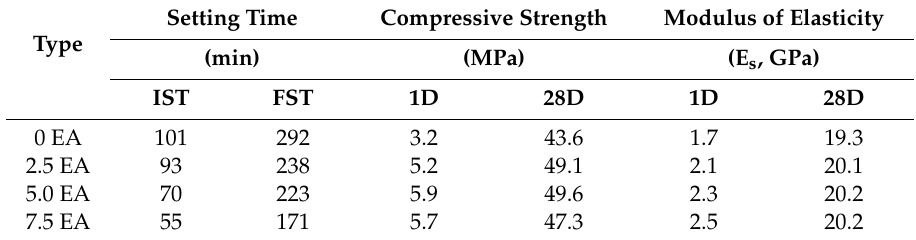
Table 3. Setting time and strength characteristics of the AAM mortar mixed with